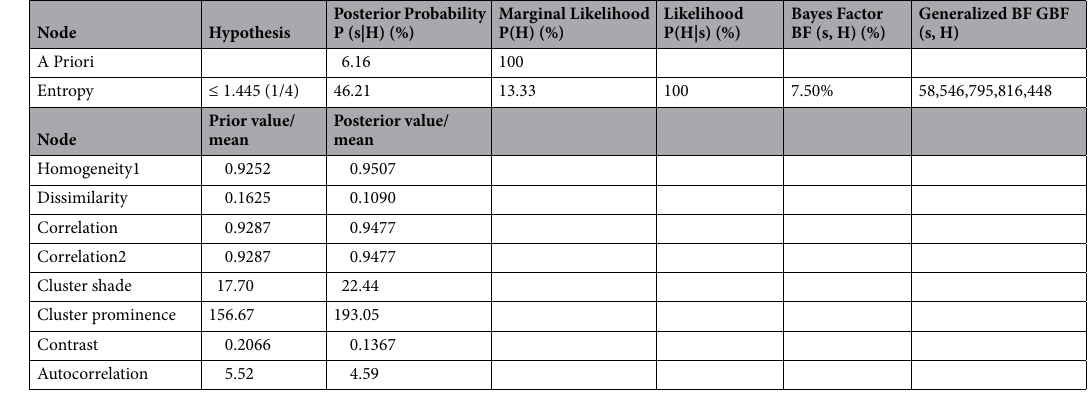
Table 8. Search method: hard evidence dynamic profile energy: probability maximization (likelihood) energy > 0.471